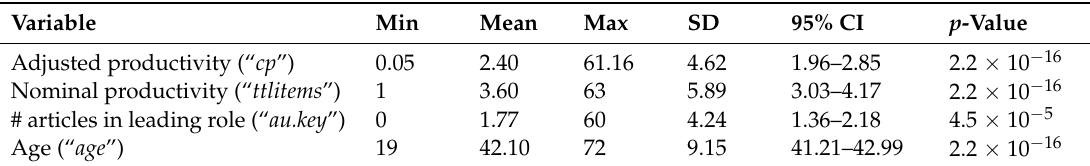
Table 1. Descriptive statistics for the variables in the